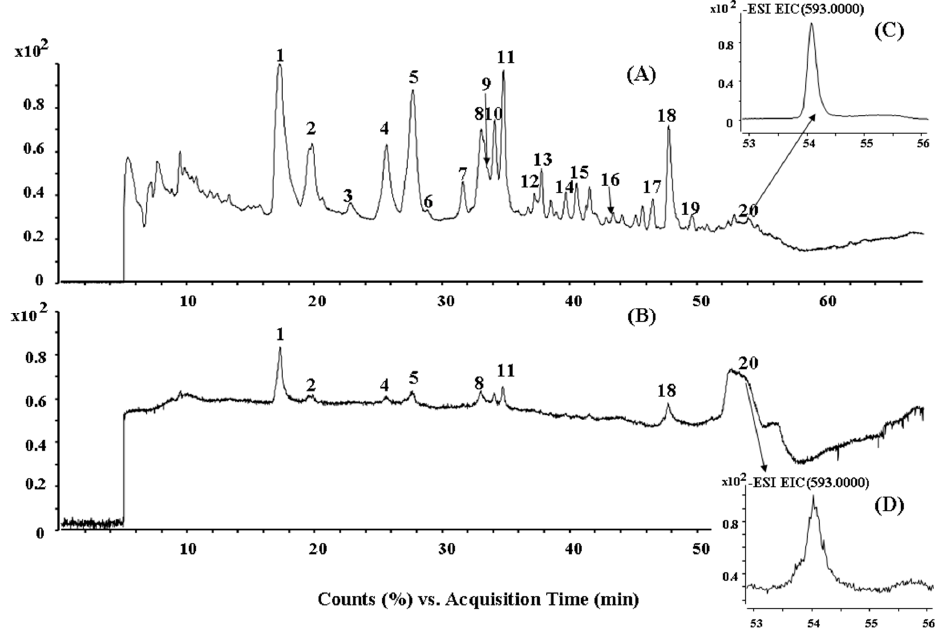
Figure 5. TIC chromatograms in the negative ion mode of ( A ) an extract of S. doederleinii and ( B ) the eight reference compounds, the extracted ion chromatograms (EIC, m / z 593) in the negative ion mode of ( C ) an extract of S. doederleinii and ( D ) the 8 reference compounds. Table 1. Peak assignments for the analysis of the extract from S. doederleinii . Peak No.